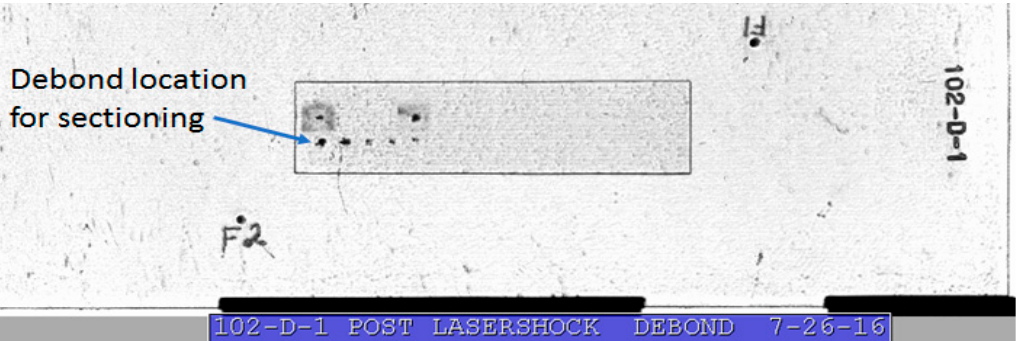
Figure 13. Location of the debond used for laser shockwave technique (LST) and section from an FF electroplated plasma fuel plate.